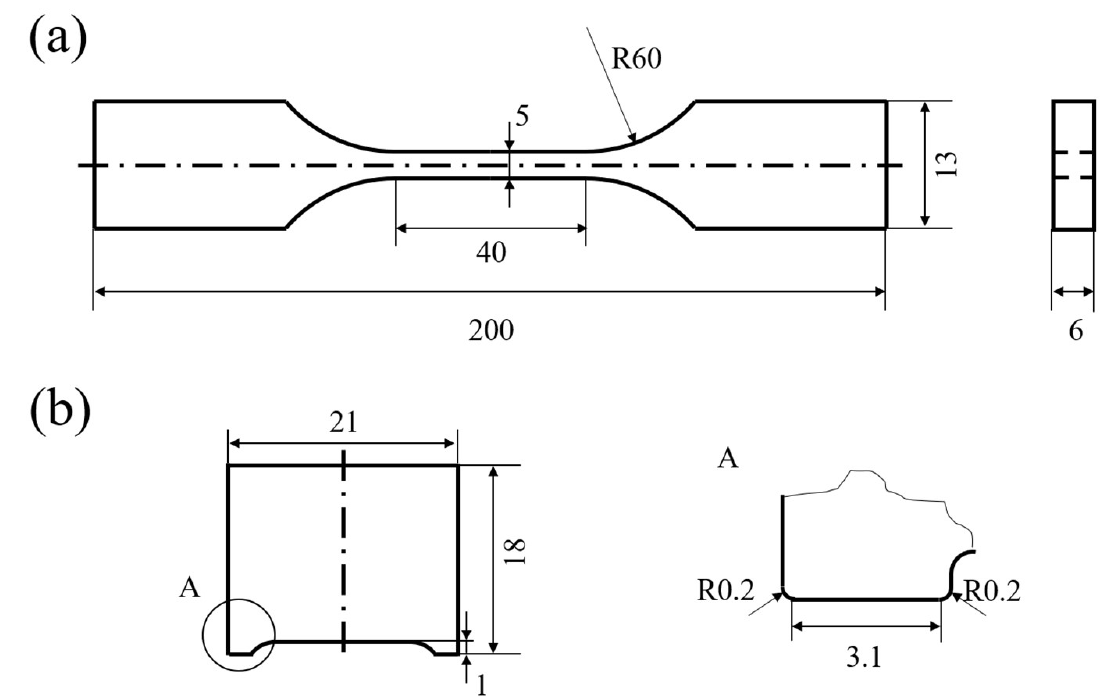
Figure 1. Dimensions of the ( a ) specimen and ( b ) fretting pad (all dimensions are in mm).